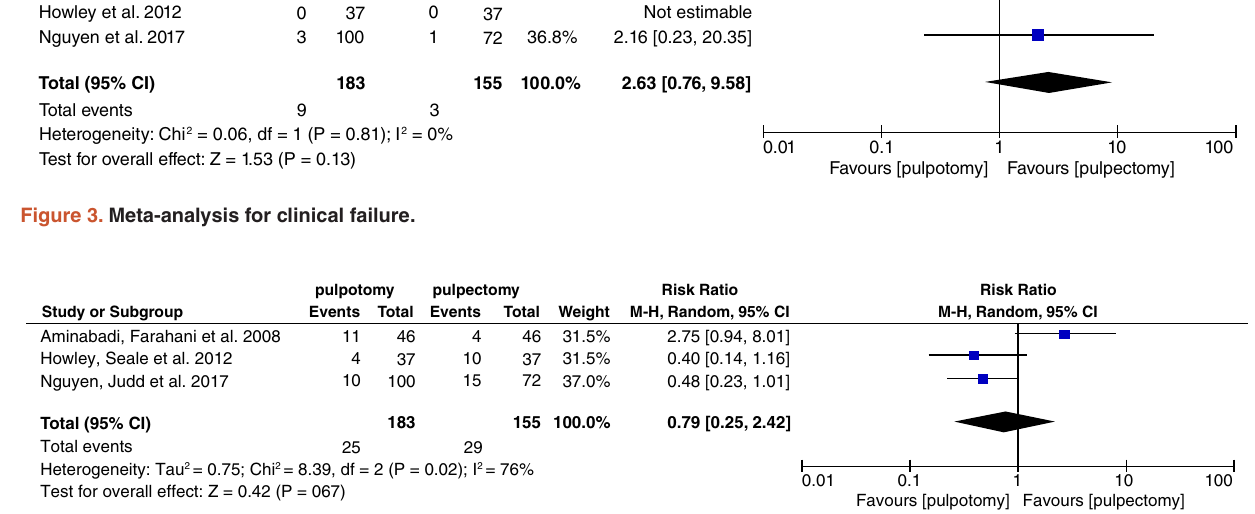
Figure 4. Meta-analysis for radiographic